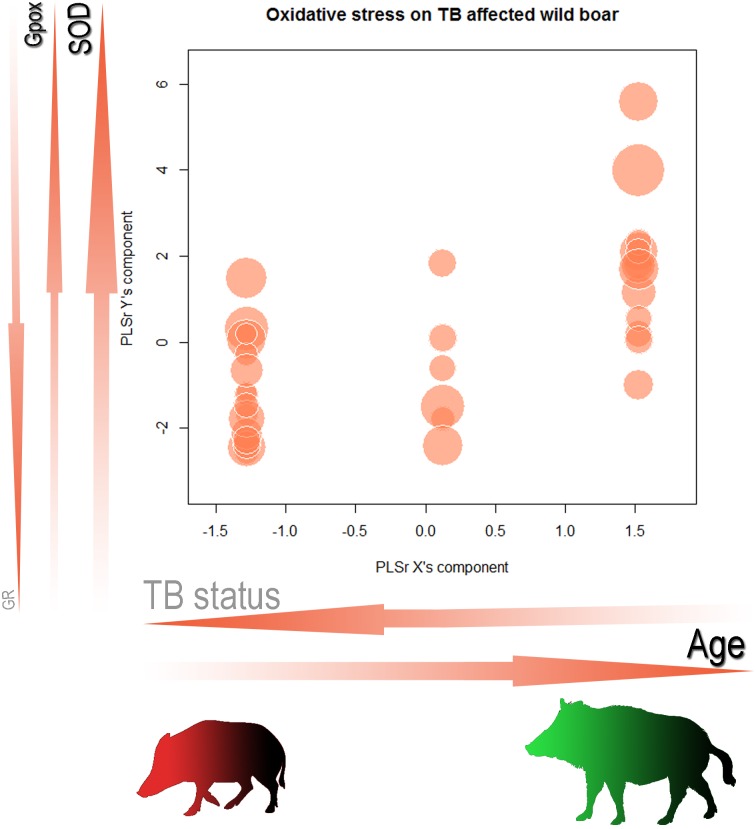
Bubble plot representing the relationships between a PLSR X component describing age and tuberculosis status and the PLSR Y component describing antioxidant capacity of 59 wild boar (Sus scrofa) experimentally infected with M. bovis.Font and arrow size indicate the weight of each variable whereas font colour indicates either the increase (black) or the decrease (grey) of the score components. Bubble diameter represents TBARS concentration (nmol MDA/ml), an oxidation biomarker. Thus, for proper interpretation both the bubble size and its position should be taken into account. Large bubbles at low PLSR Y scores suggest boars with oxidative damage whereas the same bubbles at high PLSR Y scores indicate that individuals are able to compensate for the increase in oxidation (high antioxidant /oxidant value). Each bubble represents individuals having the same X and Y score values. The red wild boar shape at the bottom represents a young wild boar suffering from oxidation due to M. bovis, whereas the green shape represents a TB-free adult wild boar in good antioxidant status.